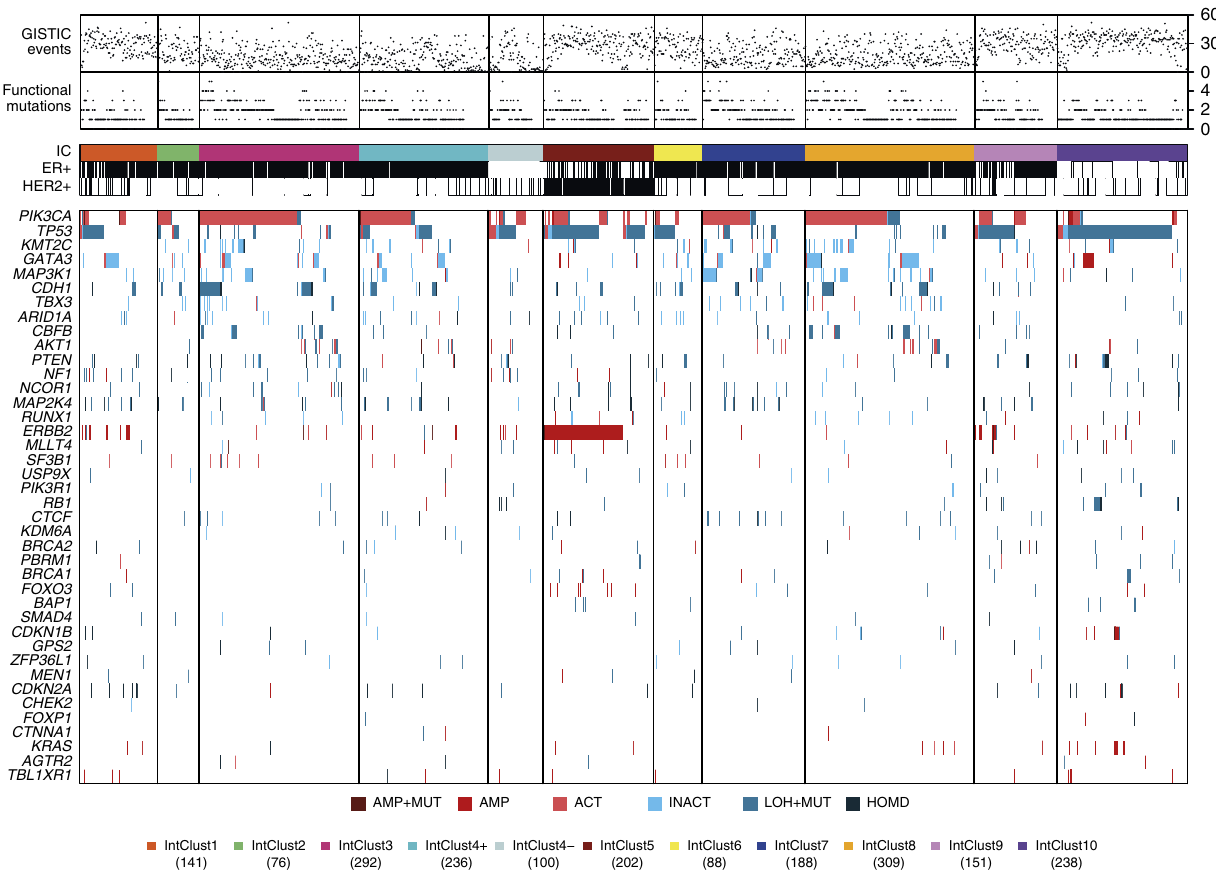
Figure 4 | Genomic profiles of the Integrative Clusters. Tumours with both mutation and copy number data available ( n ¼ 2,021) are grouped by IntClust along the x -axis, and alterations in the 40 Mut-driver genes are indicated by coloured bars. For each tumour, the number of functional mutations in Mut-driver genes and the number of recurrent CNAs (as defined by GISTIC2) events are also shown. AMP, amplification; ACT, activating mutation; HOMD, homozygous deletion; INACT, inactivating mutation; LOH þ MUT, mutation and hemizygous